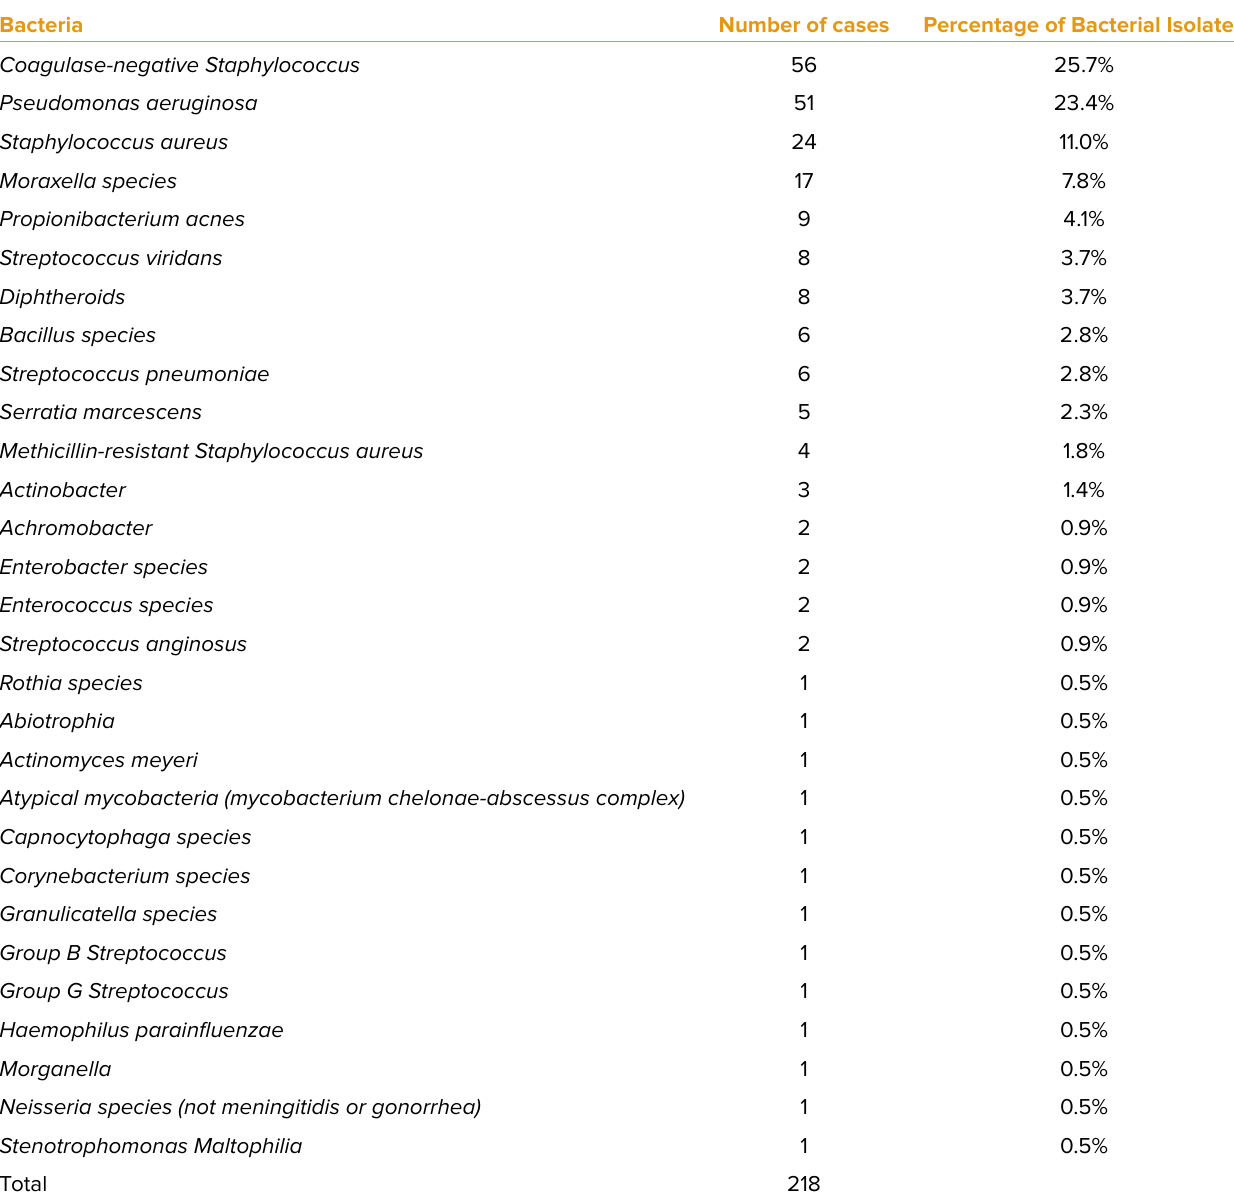
Table 1. Spectrum of bacterial isolates observed in cases with bacterial keratitis in South Texas